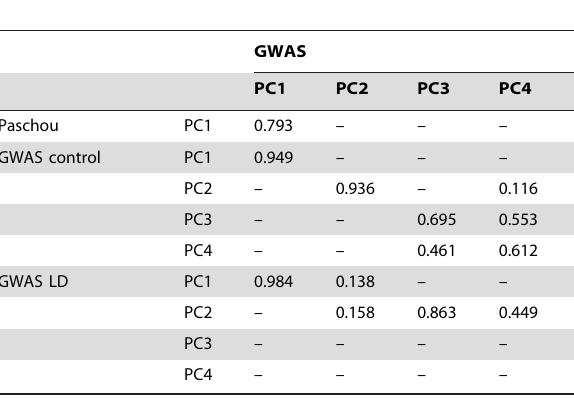
Table 3. GWAS PCA is compared to Paschou PCA, GWAS control PCA and GWAS LD